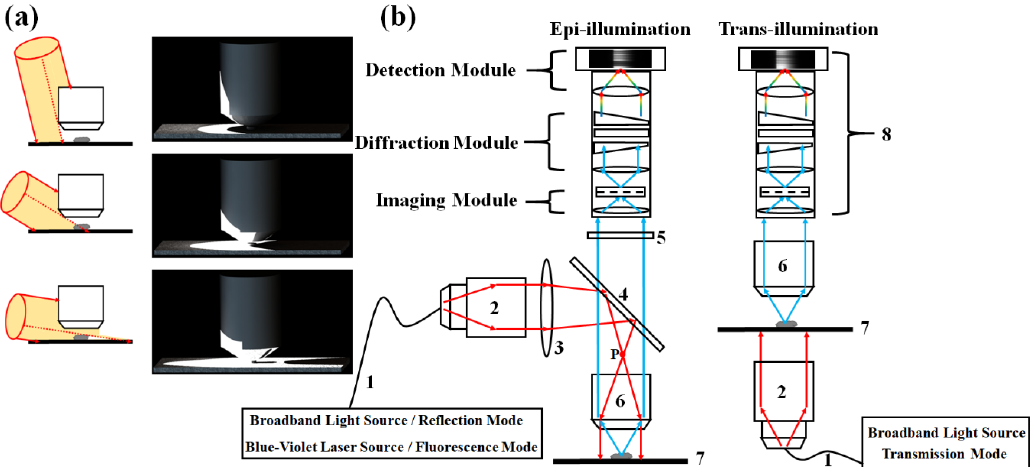
Figure 2. ( a ) Schematic diagram of shadow generation under the lateral illumination condition. ( b ) Illustration of multi-mode detections. Reflection mode and fluorescence mode use